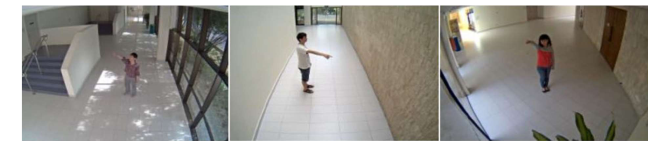
Figure 19. Samples from MCAD dataset [218].